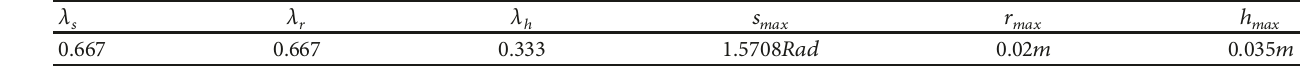
Table 8: Parameters for computing cost